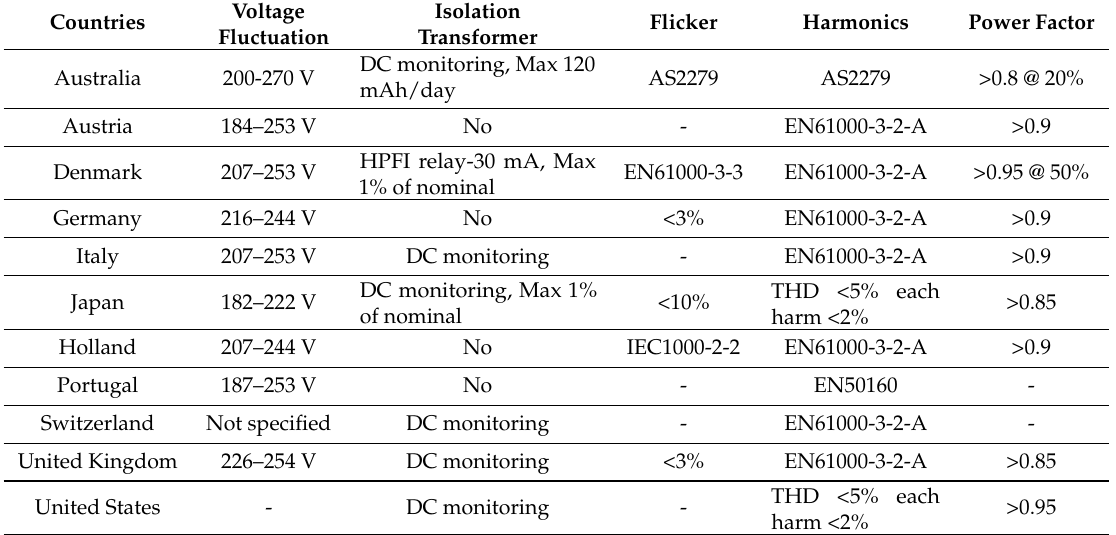
Table 3. Standards in selected IEAcountries